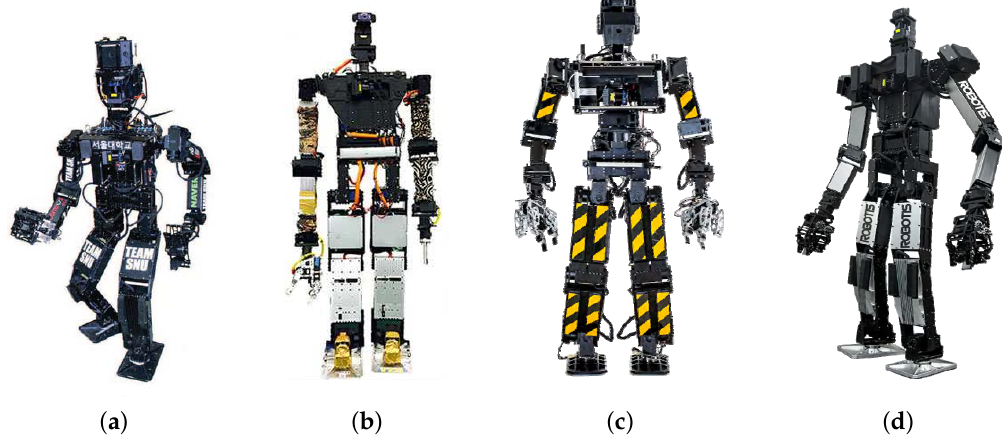
Figure 2. THORMANG platform at DRC Finals in 2015: ( a ) THORMANG, TEAM SNU (1.47 m, 60 kg), ( b ) THOR-RD, TEAM THOR (1.50 m, 54 kg), ( c ) Johnny05, TEAM Hector (1.47 m, 55 kg), ( d ) THORMANG2, TEAM ROBOTIS (1.60 m, 60